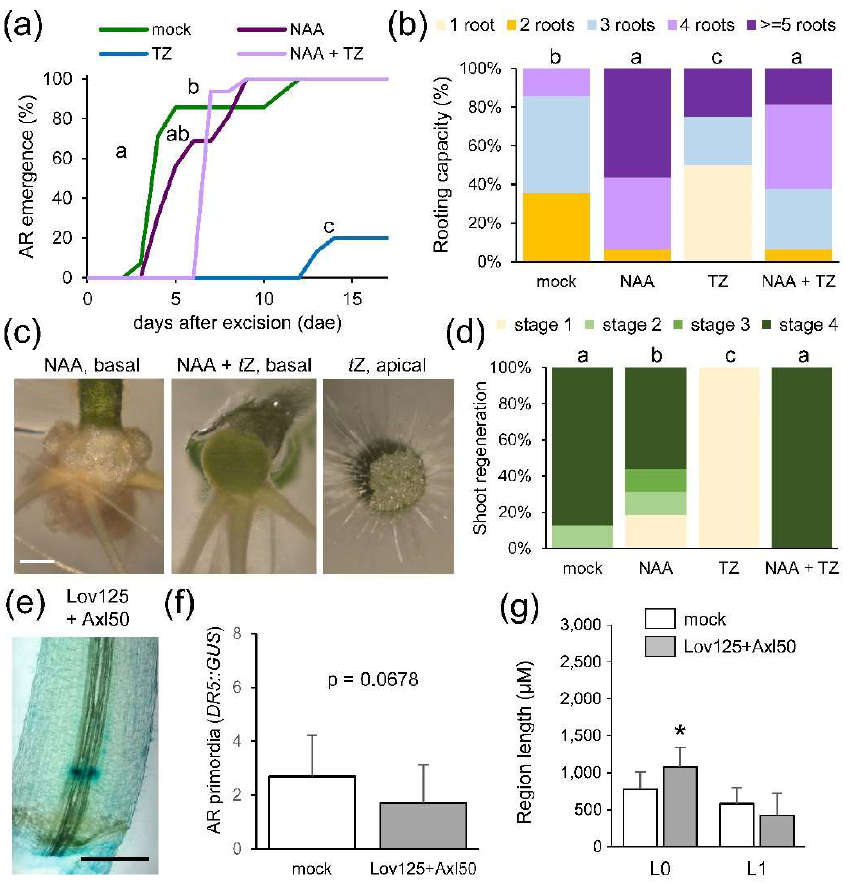
Figure 7. Auxin-to-CK ratio regulates de novo organ formation. ( a ) AR emergence of the studied explants in response to the indicated treatment; NAA: 0.3 µM NAA added to the growing medium; TZ: 0.1 µM t Z added to the growing medium; NAA + TZ: 0.3 µM NAA and 0.1 µM t Z added to the growing medium. ( b ) Rooting capacity of ‘Micro-Tom’ explants at 17 dae. ( c ) Representative images of the hypocotyl regions in the studied explants at 21 dae. ( d ) Shoot regeneration stages of ‘Micro-Tom’ explants at 17 dae. ( e ) Representative image of DR5::GUS expression in the hypocotyl explants at 48 h after Lov125 + Axl50 treatment. ( f ) AR primordia expressing DR5::GUS at 48 h. ( g ) Length of the distance to the wounding (L0) and of the AR formative region (L1) at 48 h. Different letters ( a , b , d ) and asterisk ( g ) indicate significant differences ( p -value < 0.01) between the studied treatments or regions, respectively. Scale bars in c, e: 1 mm.